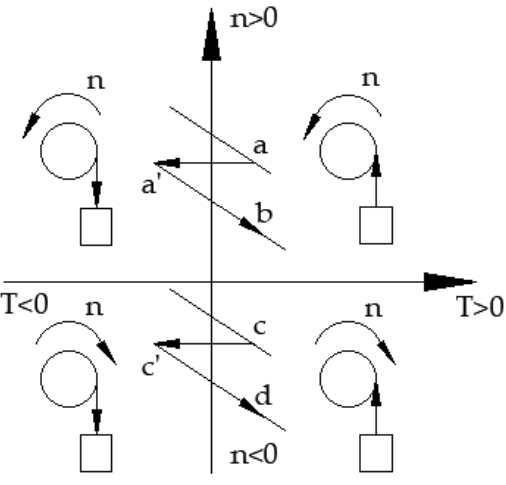
Figure 5. Motor four-quadrant operation diagram.